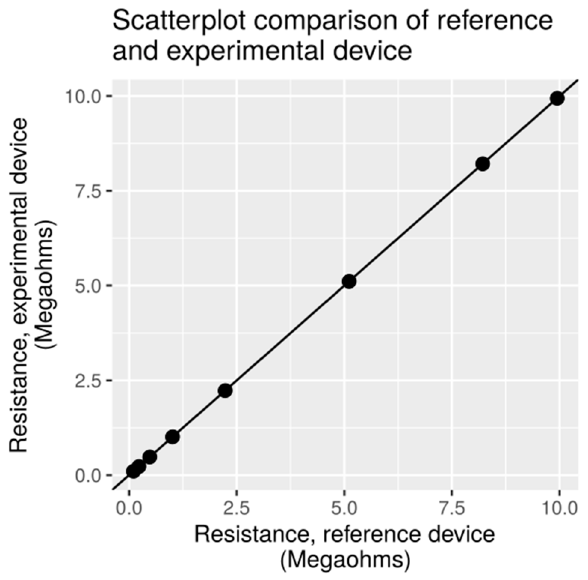
Figure 4. Bland–Altman plot of agreement between reference device and experimental transducer device.